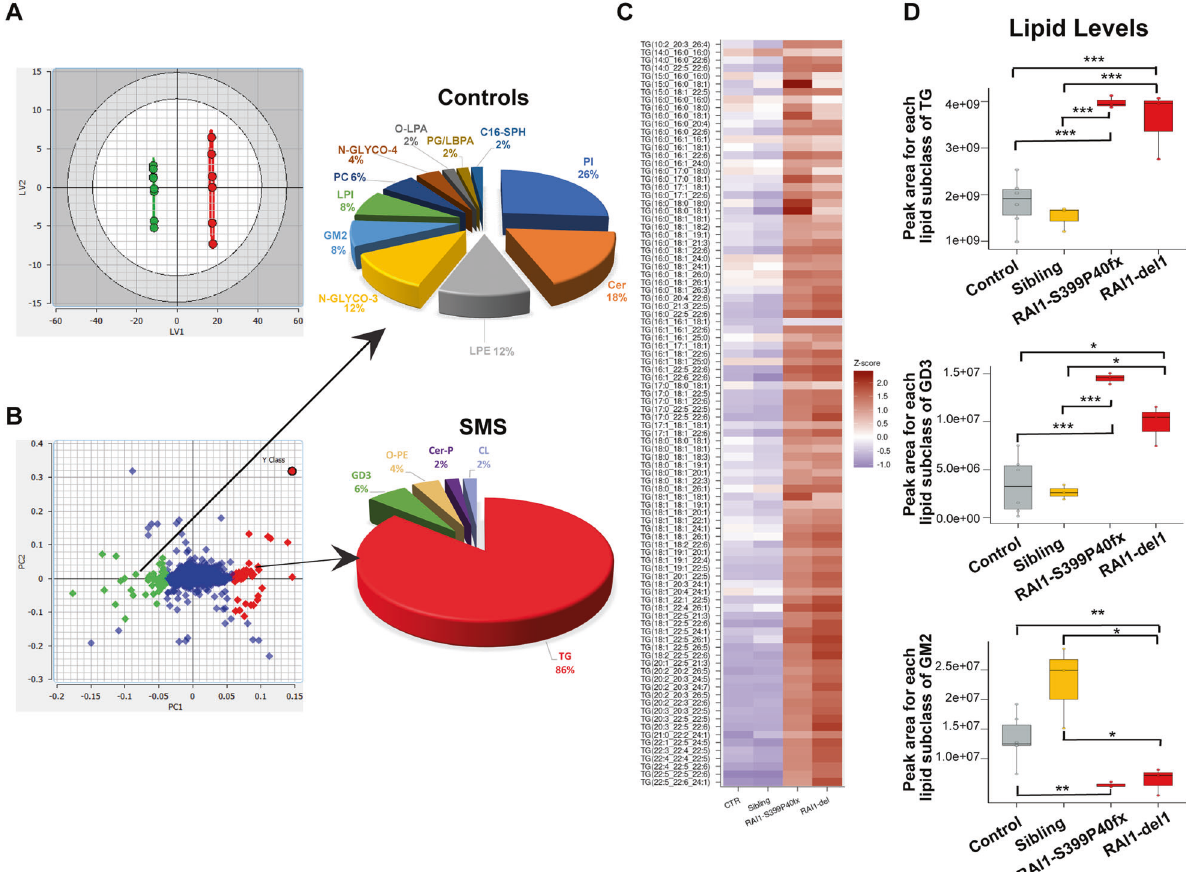
Fig. 3 RAI1 haploinsuf fi ciency alters the lipid pro fi le. A O-PLS-DA LV1-LV2 score plot of untargeted lipidomic analysis revealed distinct lipid pro fi les between SMS cells (RAI1-del1 and RAI1-S399P40fx, green) and CTRL (CTR1/2 and sibling, red) cells ( n = 3 biological replicates). B O- PLS-DA LV1-LV2 weight plot. The 100 most discriminant lipids are colored red (higher in SMS samples) and green (higher in control samples). The compositions of the 50 most representative lipids in the control and SMS samples are shown. C Heatmap of triglycerides. D Box plots showing the relative TG and GM2/GD3 ganglioside abundances in control, SMS and CTR cells. The relative abundance was derived by adding the peak area for each lipid subclass identi fi ed by LC – MS and Lipostar software. The boxplots show the medians (horizontal lines), 25th – 75th percentiles (box outlines), and highest and lowest values within 1.5x of the interquartile range (vertical lines). Graphs: mean ± SEM, one-way ANOVA + Newman – Keuls post hoc test, * p < 0.05, ** p < 0.01, *** p <